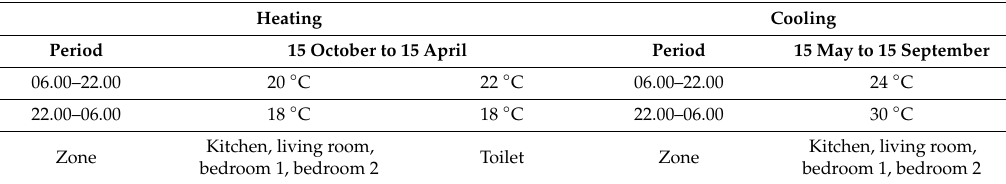
Table 2. Setpoint